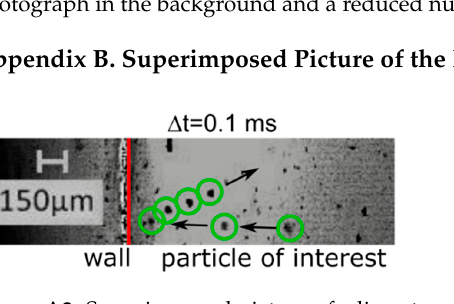
Figure A1. ( Left ) Shows the experimental PIV setup with the camera facing the side of the classifier wheel and the laser facing the front. ( Right ) Shows a picture of the evaluation with an unprocessed photograph in the background and a reduced number of valid vectors for improved visibility.